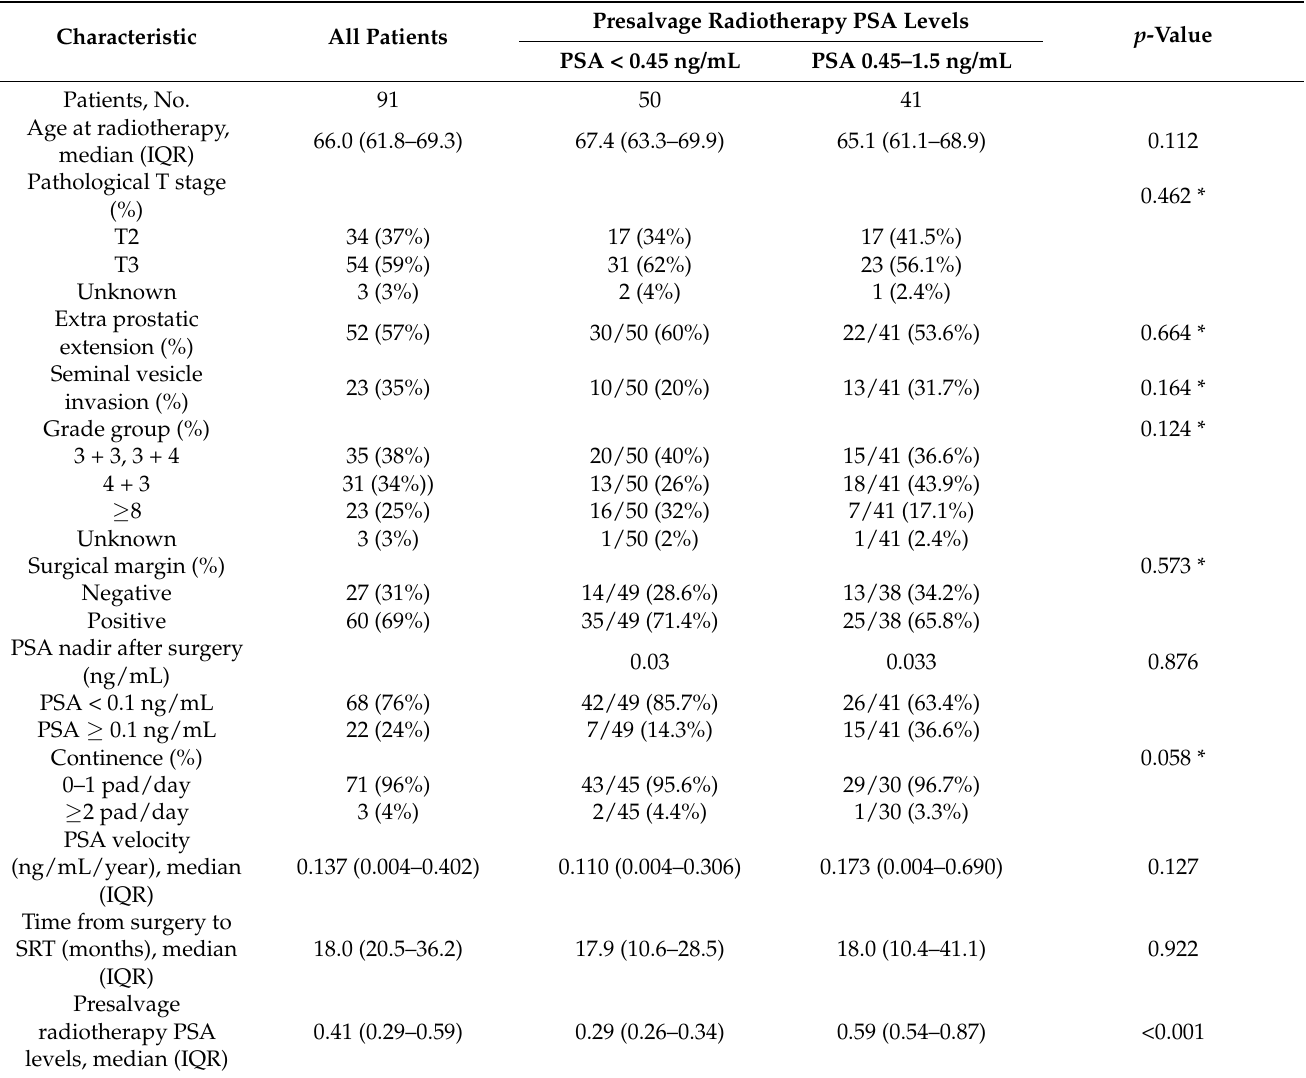
Table 1. Clinical characteristics of patients undergoing salvage radiotherapy for recurrence after radical